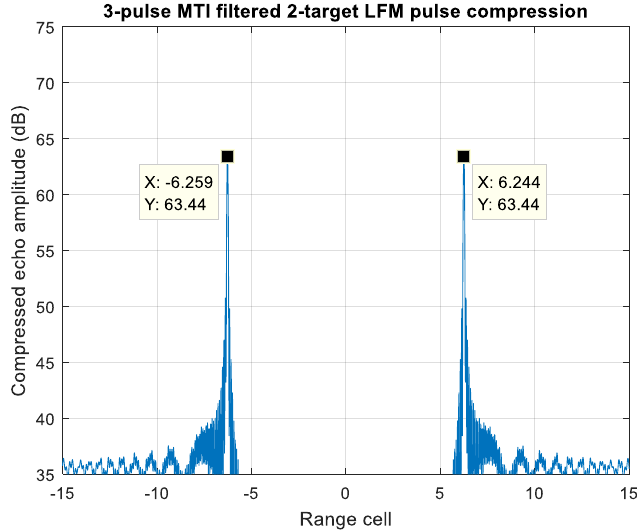
Figure 22. A 3-pulse MTI filtered echo of two overlapped targets. Target one is zero Doppler, while target two is at f d 2/PRIL = 0.32.